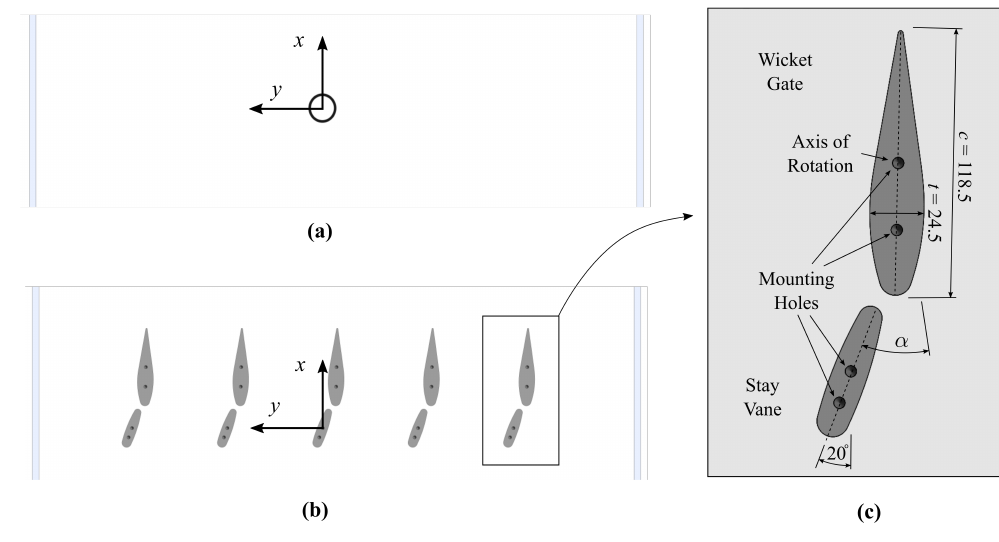
Figure 3. Collision geometry: ( a ) cylinder and ( b ) stay vane and wicket gate array. The details of the stay vane and wicket gate configuration is shown in ( c ).